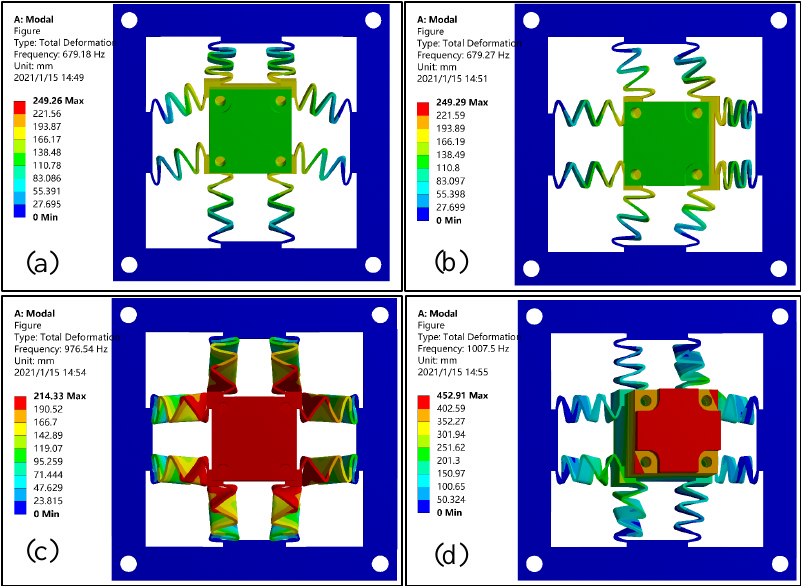
Figure 7. Simulated mode shapes: ( a ) first, ( b ) second, ( c ) third, and ( d ) fourth